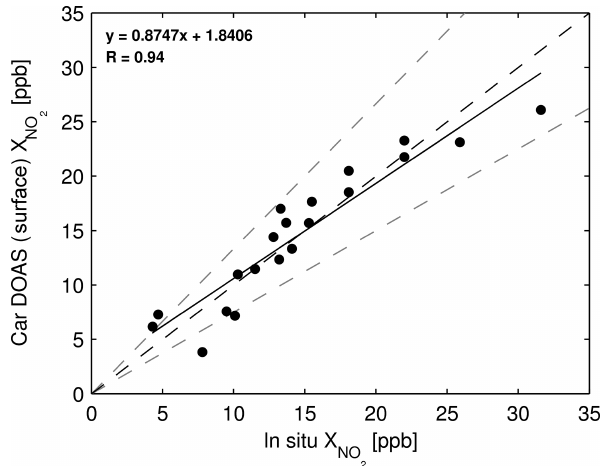
Figure 19. Estimated path-averaged NO 2 mixing ratios obtained from tower DOAS off-axis measurements recorded during two tower platform rotations on 29 April and 9 May